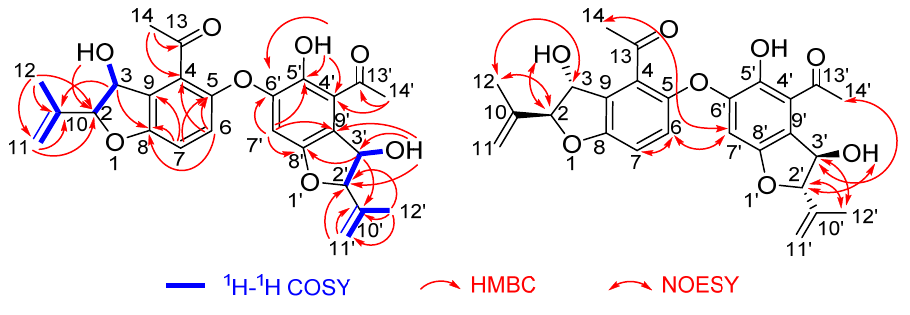
Figure 2. Key 2D NMR correlations for 2 .